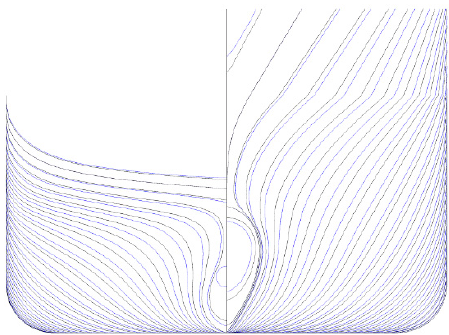
= 0.661 (black line) and C